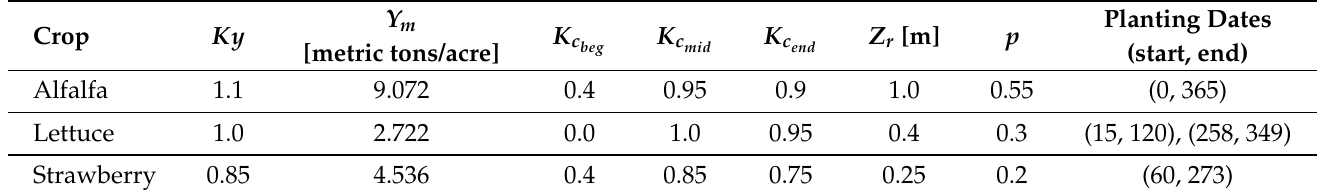
Table 2. Crop parameters used in this study